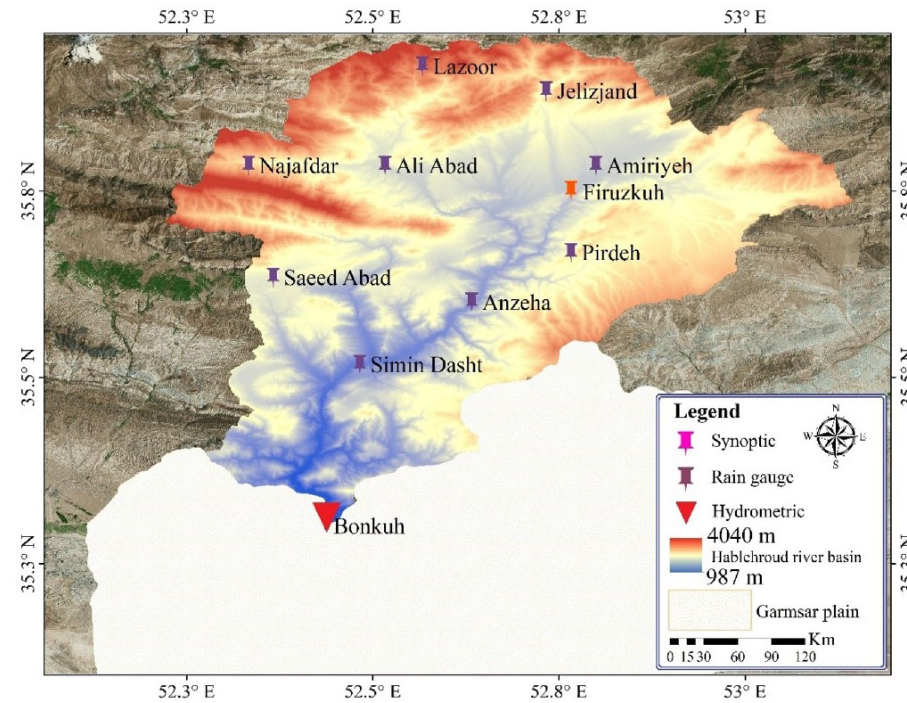
Fig. 2 The location of the Hablehroud